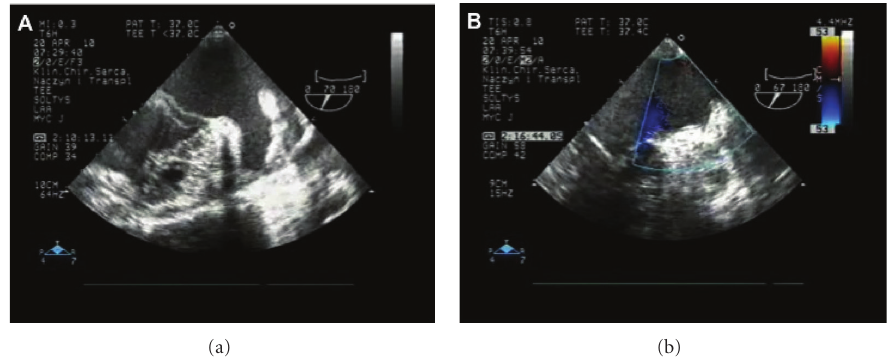
Figure 7: Transesophageal echocardiographic images of the left atrial appendage (a) prior to and (b) immediately after LARIAT suture deployment, highlighting acute LAA exclusion. ( Image courtesy of SentreHeart, Inc. )